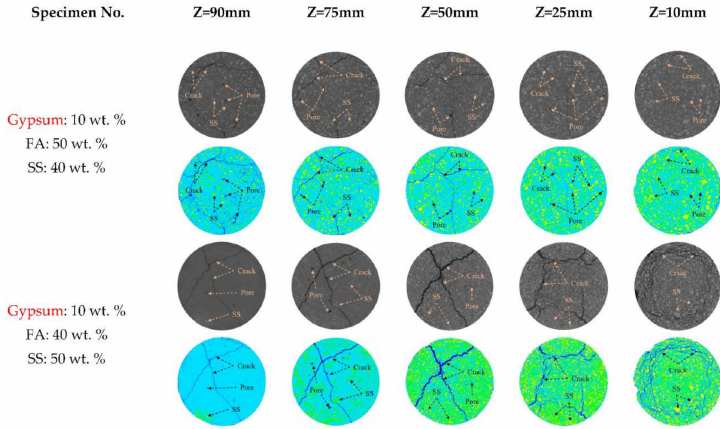
Figure 6. The CT images of different heights of CBC samples (C/SW ratio was 1:12).